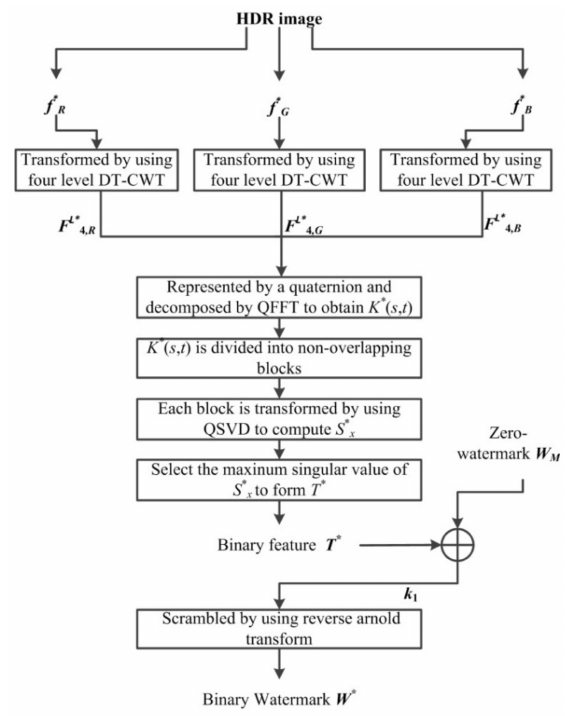
Figure 4. Flowchart of zero-watermark